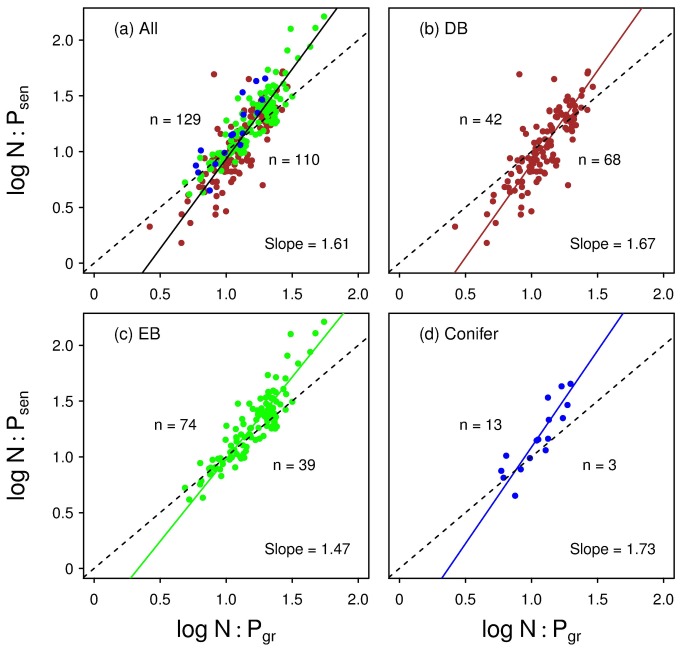
Standardized major axis regression (solid lines) for log10-transfromed N:P ratio in senesced against green leaves of (a) all species, (b) deciduous (DB) and (c) evergreen (EB) angiosperms, and (d) conifers.The dash lines denote the 1:1 lines, above and below which the numbers of data points are shown.